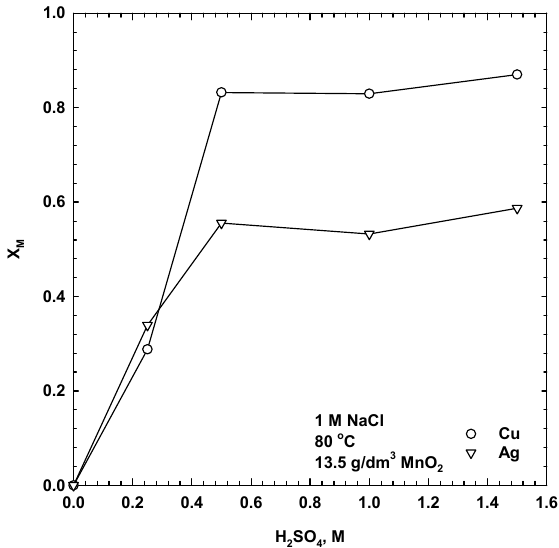
Figure 5. Influence of acid concentration on dissolution of copper and silver (80 °C, 1 M NaCl, 13.5 g/dm 3 MnO 2 , 30 g/dm 3 SMS, 300 rpm, leaching time 24 h).